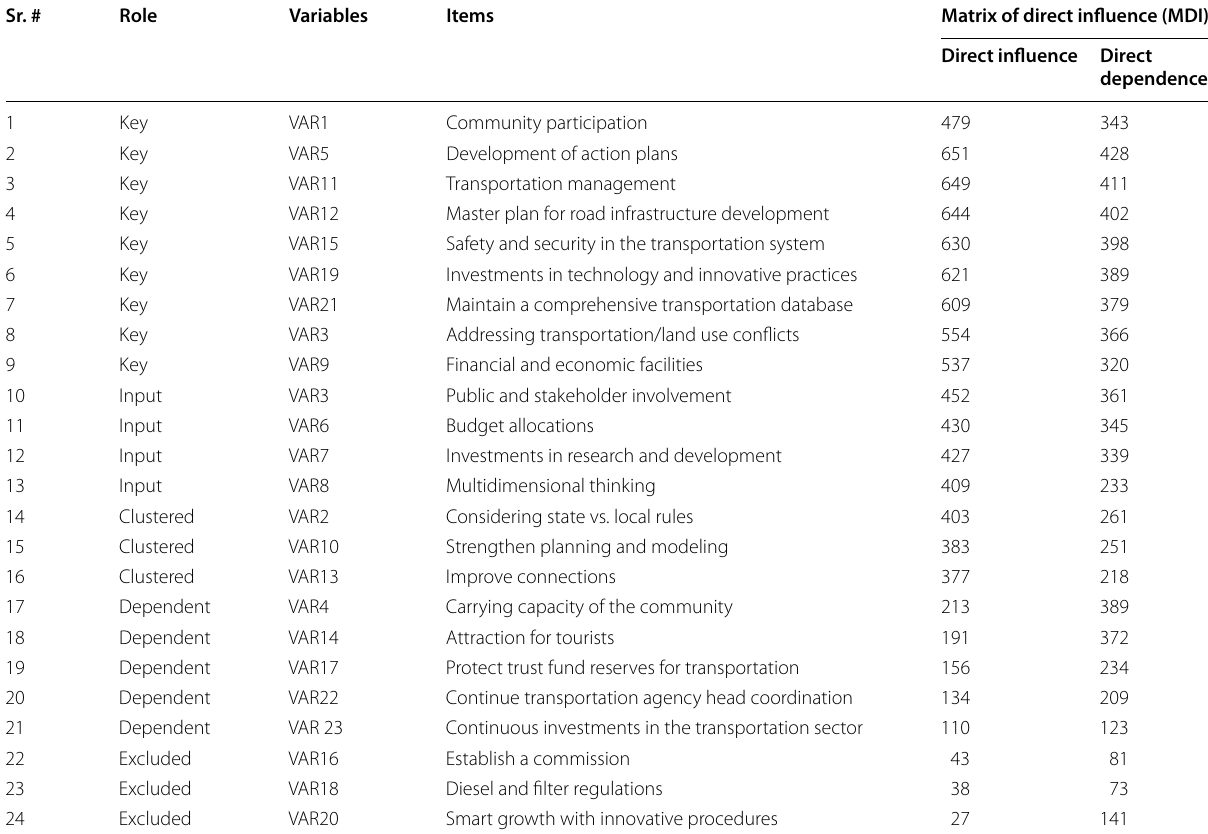
Table 3 Direct influence and dependence of constructs Sr.